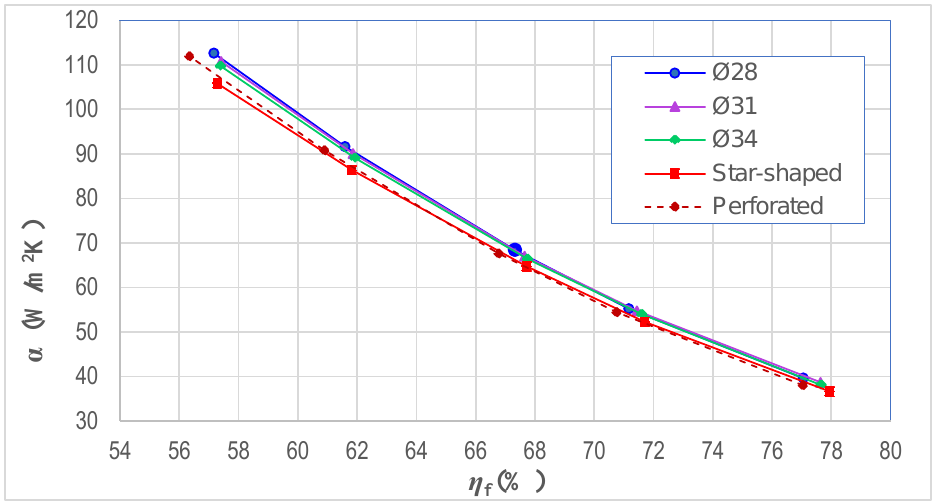
Figure 14. Heat transfer coefficient versus fin efficiency.